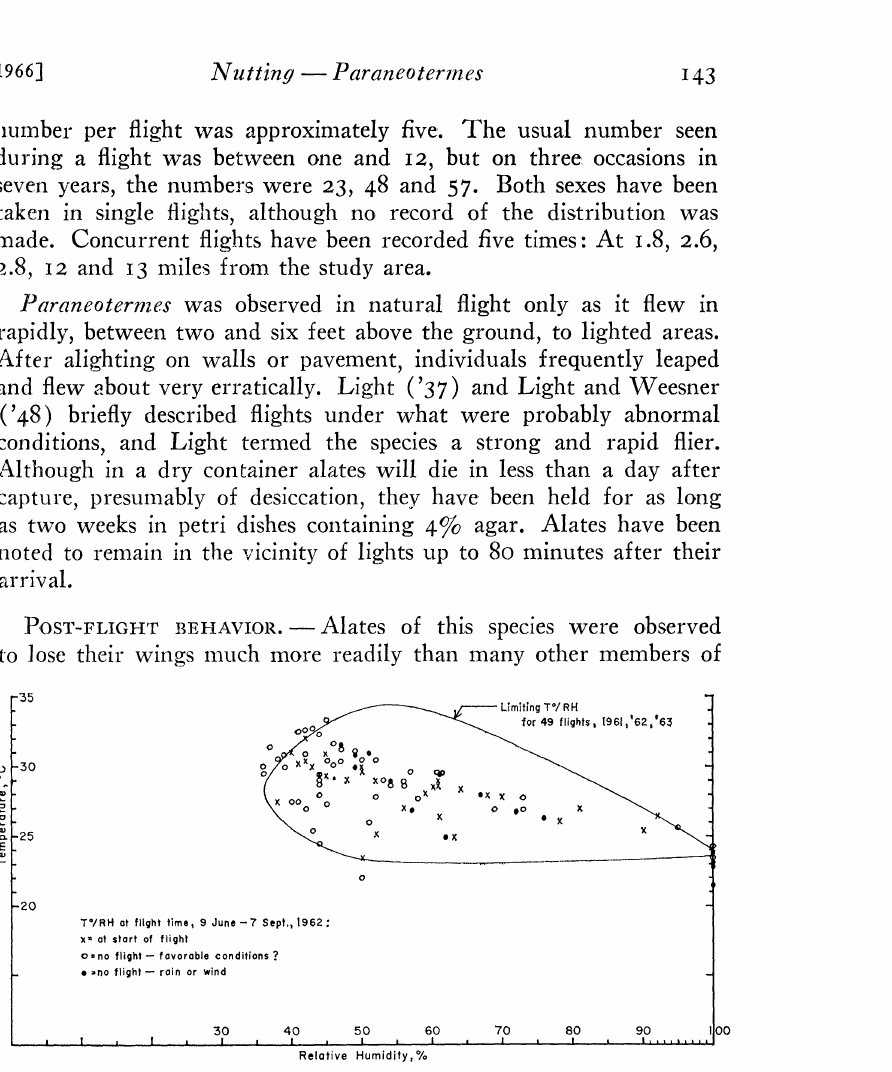
Figure 6. Combinations ot temperature and relative humidity at approxi- mate flight time (sunset plus 15 rain.) or Paraneotermes simplicicornis at Tucson, Arizona. The limits ot these conditions for 49 flights are shown by the closed curve. Conditions tor the 91 evenings in the 1962 flight season are plotted as follows: x, at the start of 29 flights; solid circles, at flight time on 15 evenings when flights may have been prevented by rain or wind; open circles, at flight time on 47 evenings when no flights were ob- served. In the latter case these conditions could have been limiting on 13 evenings where they ell outside the